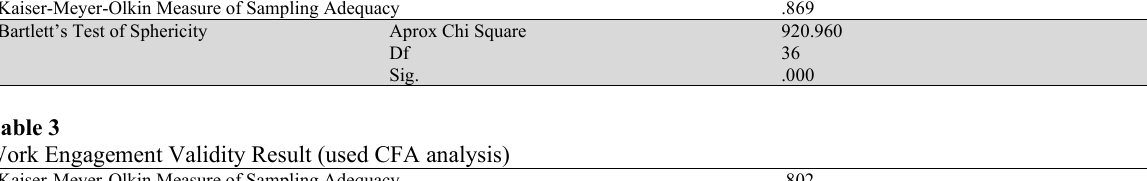
Work Engagement Validity Result (used CFA analysis) Kaiser-Meyer-Olkin Measure of Sampling Adequacy .802 Bartlett’s Test of Sphericity